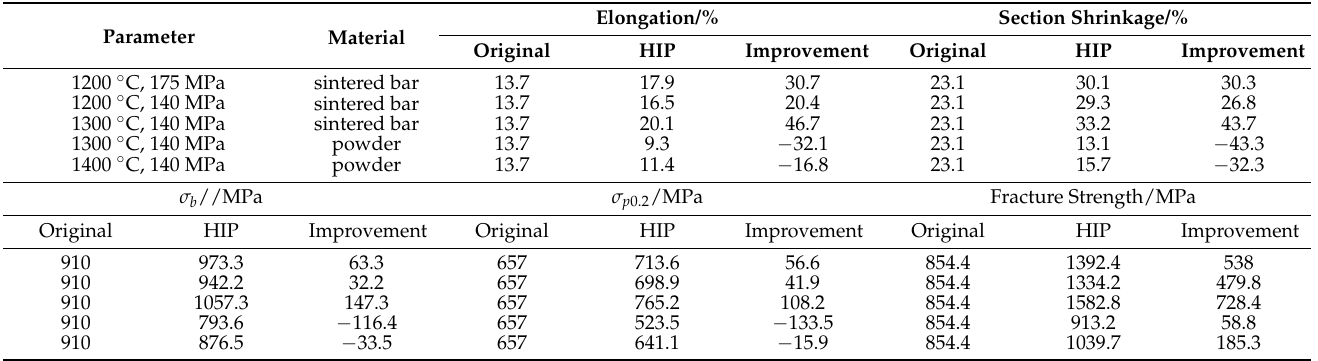
Table 5. Comparison of mechanical properties under different process